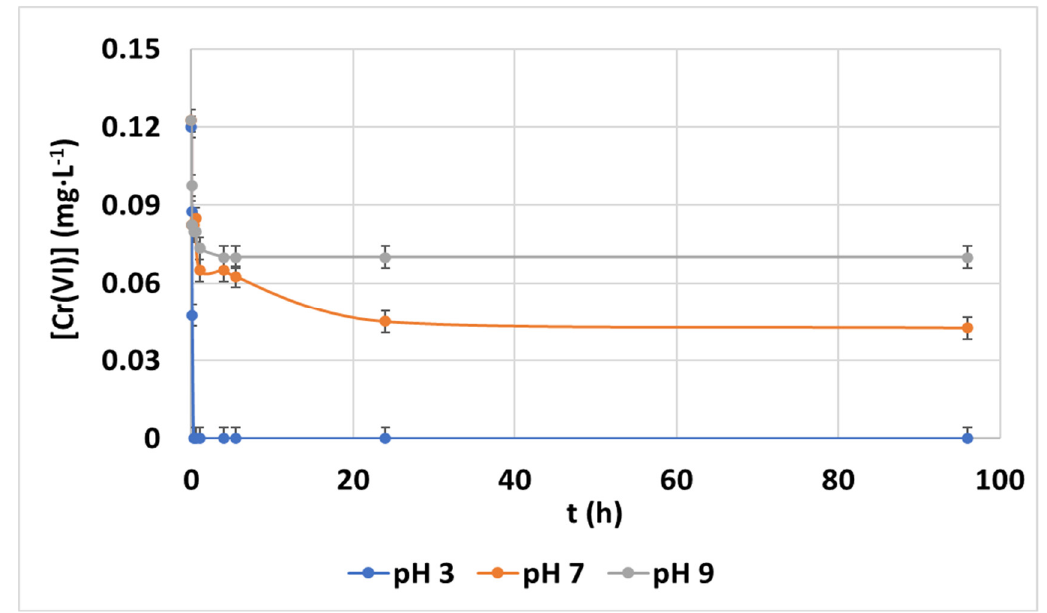
Figure 2. Evolution of hexavalent chromium concentration (mg·L −1 ) during adsorption batch experiments with CCNC with contact time at 0.1 mg·L −1 of initial chromium concentration, 100 mg·L −1 of CCNC dosage at room temperature at pH values 3 to 9.